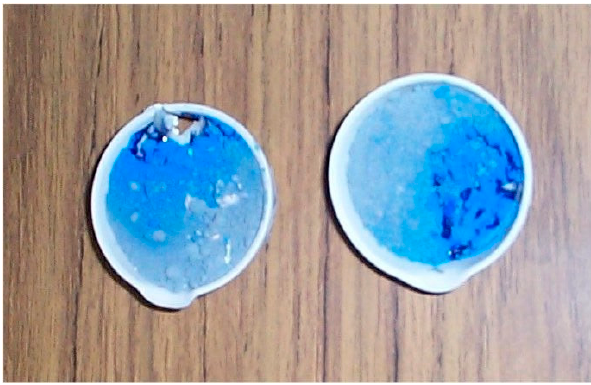
Figure 3. Thermal runaway occurring in samples processed in multi-mode applicators, at 2.45 GHz, for power density exceeding 60 W/g.